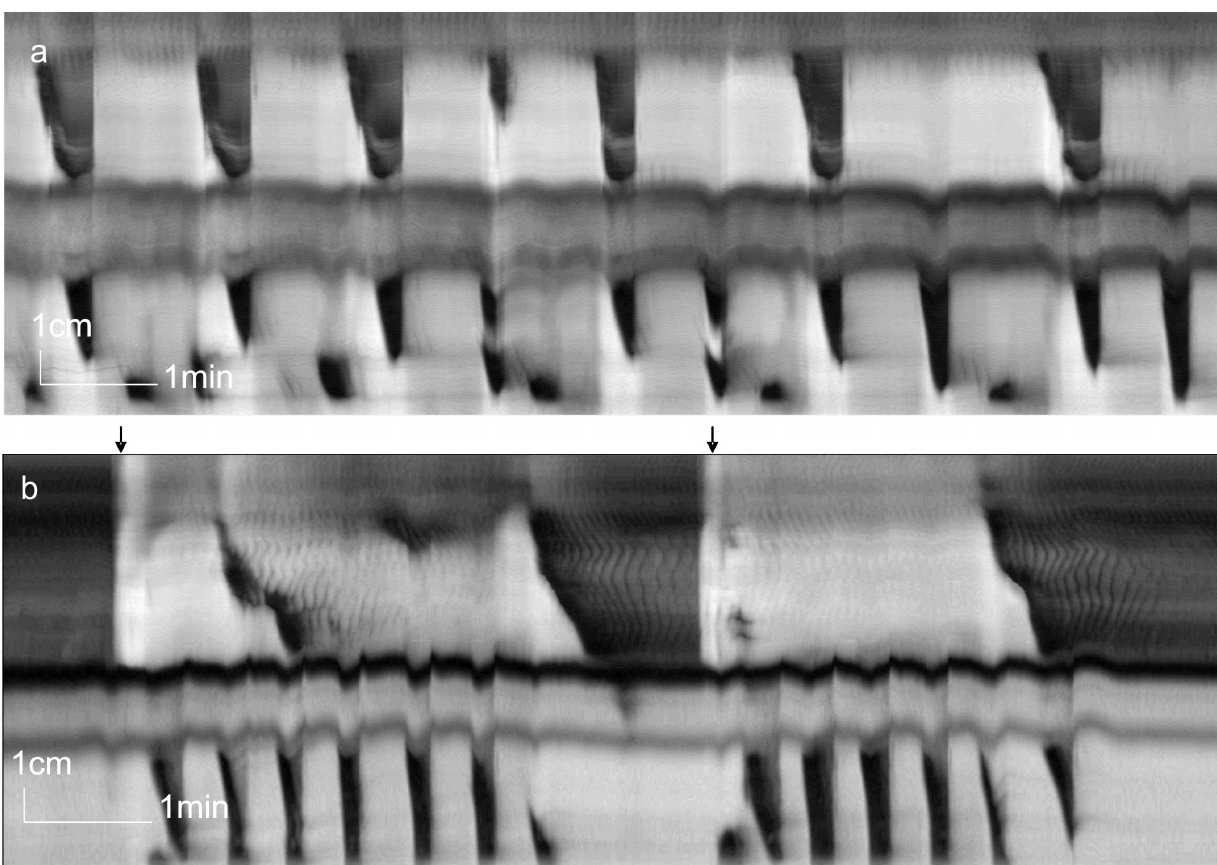
Figure 2. Influence of a sustained contraction/distention on the LDC. Spatiotemporal maps created from video recordings of motor patterns of the whole rat colon. a. A sustained contraction was present in the mid colon. LDCs started in the proximal colon and were interrupted by the sustained contraction but proceeded normally at the distal end of the sustained contraction. In addition, three contractions were seen that started at the distal end of the sustained contraction. They fall under the definition of RPMCs. b. A sustained distention, preceded and followed by a narrow ring contraction, was present in the mid colon. The LDCs in this experiment were exceptionally long in duration. The LDCs did not proceed after the contraction. In between the LDCs, RPMCs were initiated at the distal side of the sustained